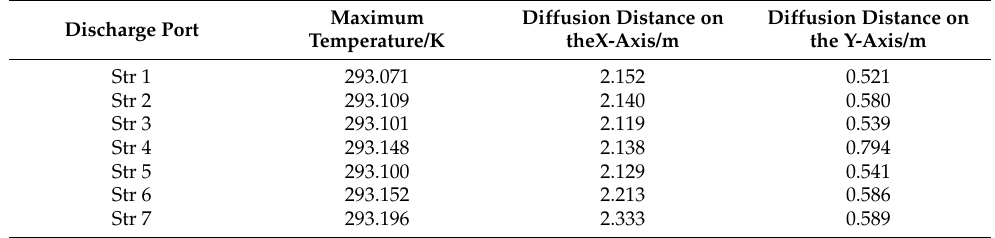
Table 2. Surface temperature values of thermal jets for different radius ratios of oval discharge ports.